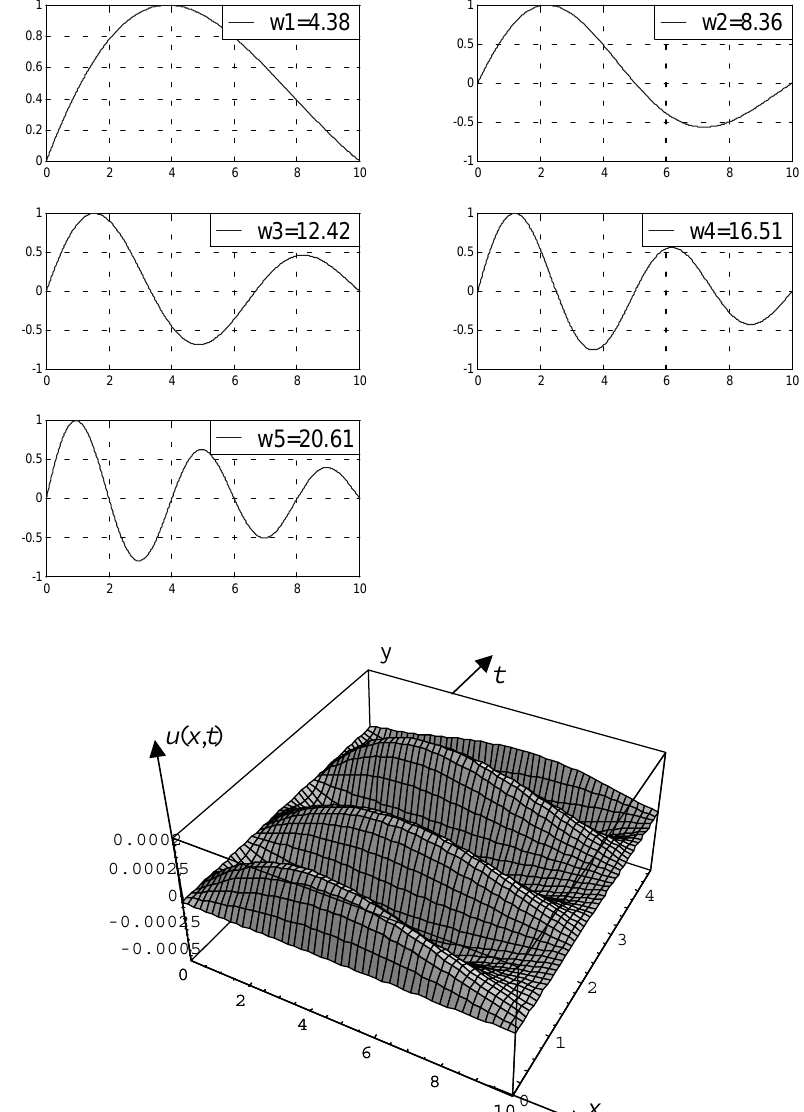
Fig. 8. First five eigenfunctions and time response of an aluminum fixed-fixed rod with an exponentially increasing density and modulus of elasticity. parameters is capable of producing a simultaneous improvement of vibration confinement and rod resistance to